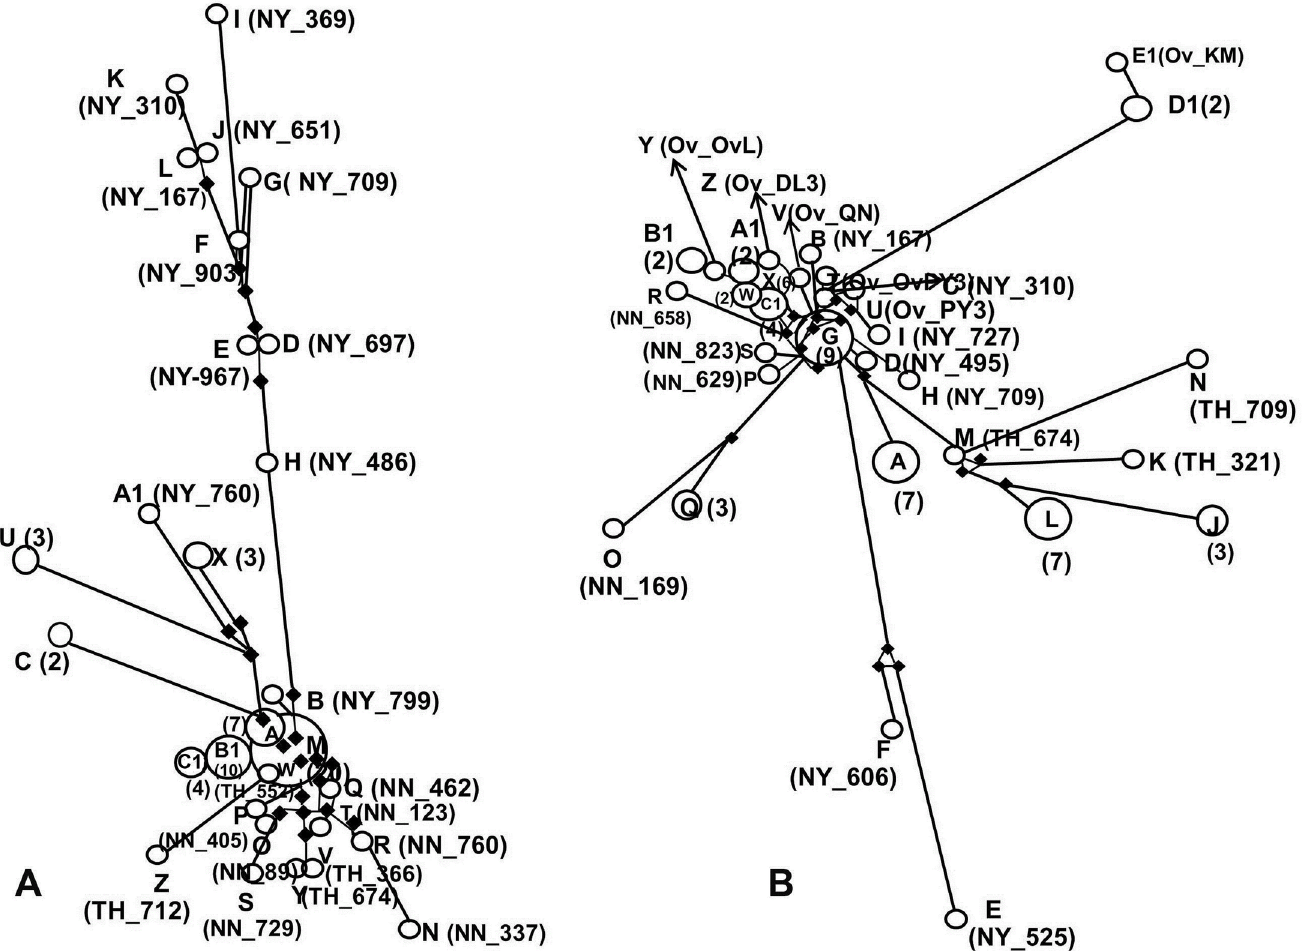
Fig 3. The haplotype networks of cox1 and nad1 sequences of O . viverrini isolated from three villages in central Thailand, reference isolates from Thailand, Lao PDR, Vietnam and Cambodia. (A) The haplotypenetwork of 29 haplotypes basedon cox1 sequences. HaplotypeM contains20 isolates and shows highestfrequency; seven isolates from Thoong-Heang Village(TH), 12 isolates from Na-Ngam Village(NN), and one isolatefrom Lao PDR. Twenty two singletons are obtainedas shownin smallest circles; 10 singletons(HaplotypeB, D, E, F, G, H, I, J, K and L) from Na-Yao Village(NY), seven singletons (HaplotypeN, O, P, Q, R, S, and T) from Na-NgamVillageand five singletons (V, W, Y Z and A1) from Thoong-Heang Village.The reference isolates from Thailand and Lao PDR are groupedin HaplotypeB1 and C1. (B) The haplotypenetwork of 31 haplotypes using nad1 sequences. HaplotypeG presents the highest frequency of 9 isolates; 7 isolates from Na-Ngam Village,one isolatefrom Na-YaoVillage and one isolate from Lao PDR. Twenty singletons are demonstrated; seven singletons (HaplotypeB, C, D, E, F, H and I) from Na-YaoVillage,three singletons(HaplotypeI, K, M and N) from Thoong-Heang Village,four singletons(Haplotype O, P R and S) from Na-NgamVillage,five singletons (HaplotypeT, U, V, Y and Z) from Vietnam and one singletons (HaplotypeE1) isolatefrom Lao PDR. The reference isolates from Thailand, Lao PDR, Vietnam and Cambodiaare clustered in HaplotypeX, A1, B1, C1 and D1. Each open circle represents each haplotypeand the numbers of each haplotypewere placed in parentheses. Each singletonis marked with the names for villagesand isolates. The solid line shows the network relationshipof the haplotypes. The frequency of nucleotide change betweenhaplotypes is shown as black